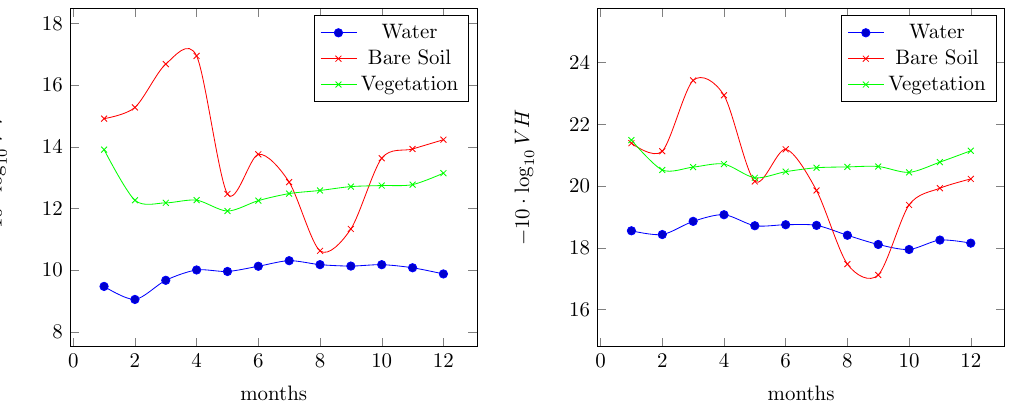
Figure 3. Multi-temporal information about the considered VV and VH polarisations, month by month, where with VV and VH we denote the σ 0 of these two